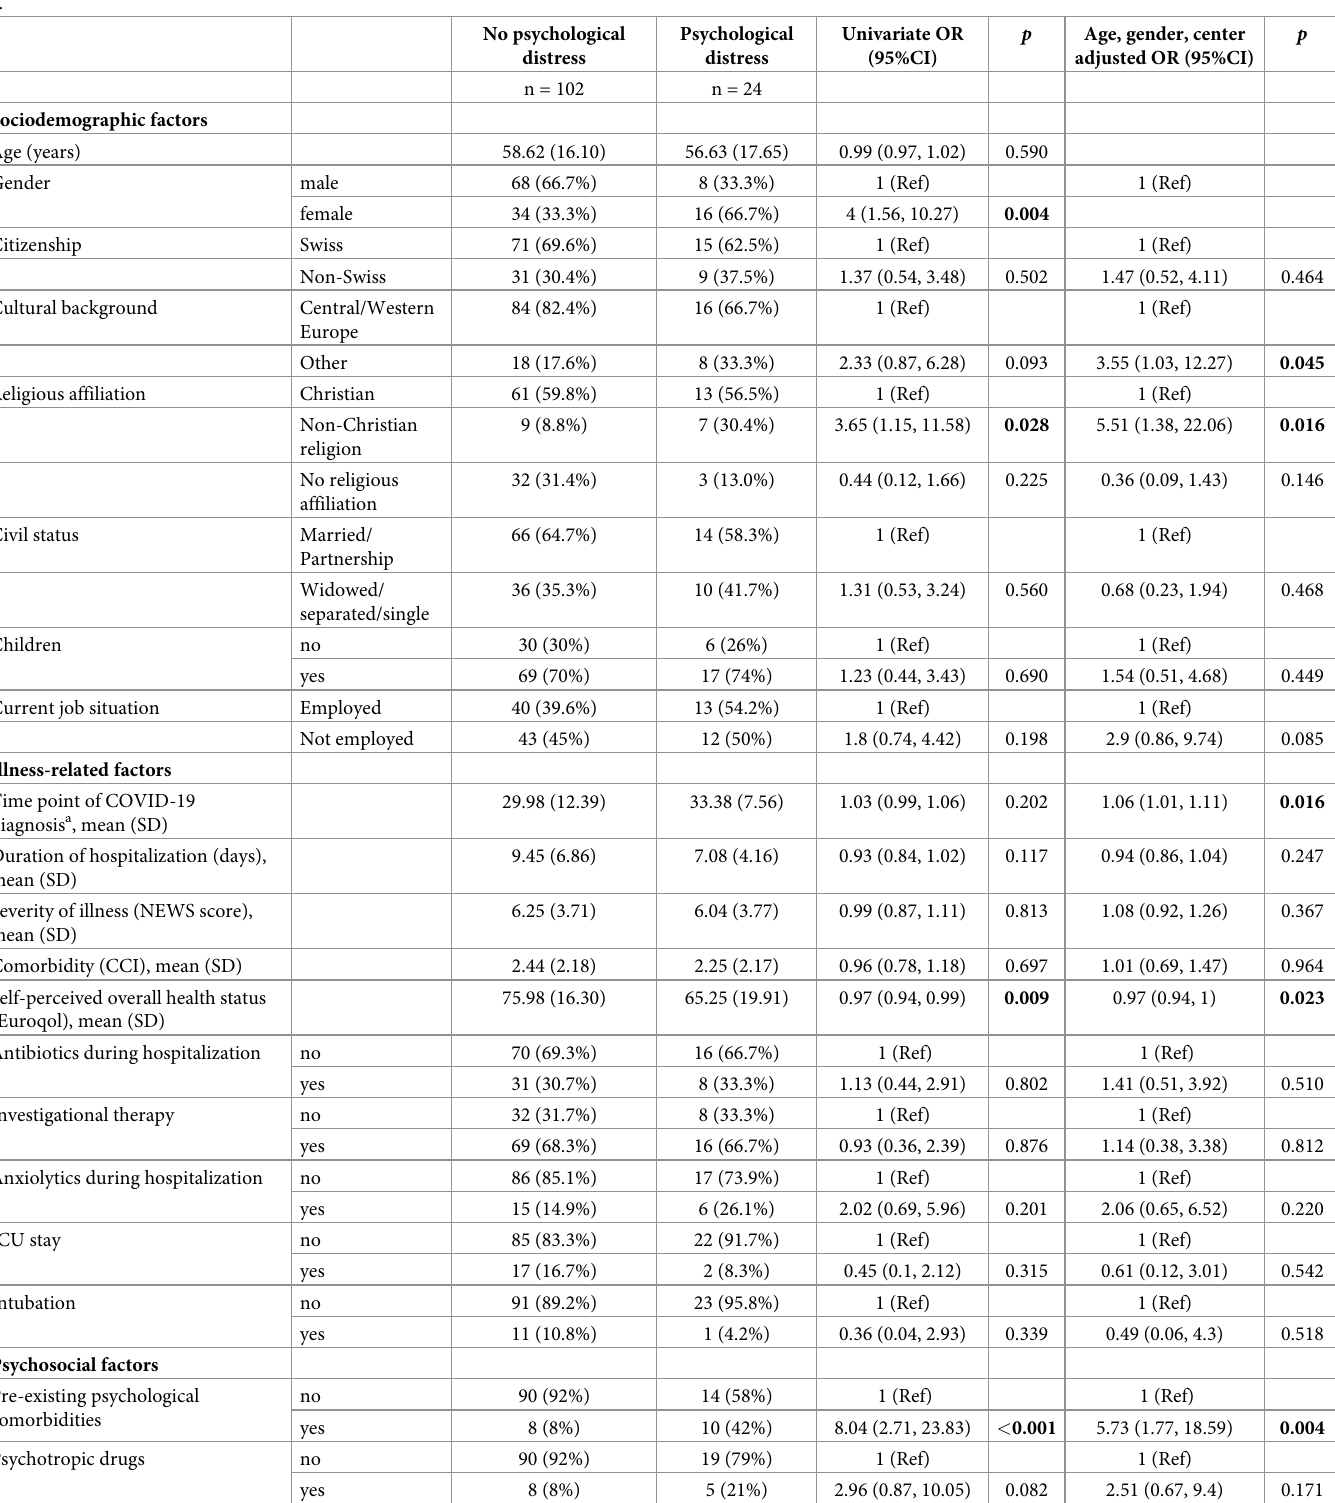
Table 2. Factors associated with psychological distress in